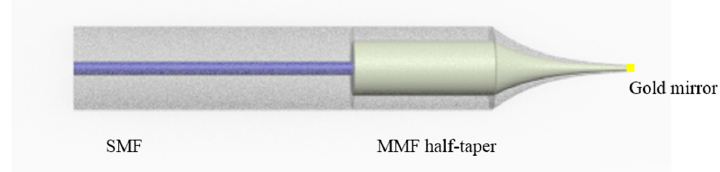
Figure 8. Schematic of a tapered multimode fiber tip.